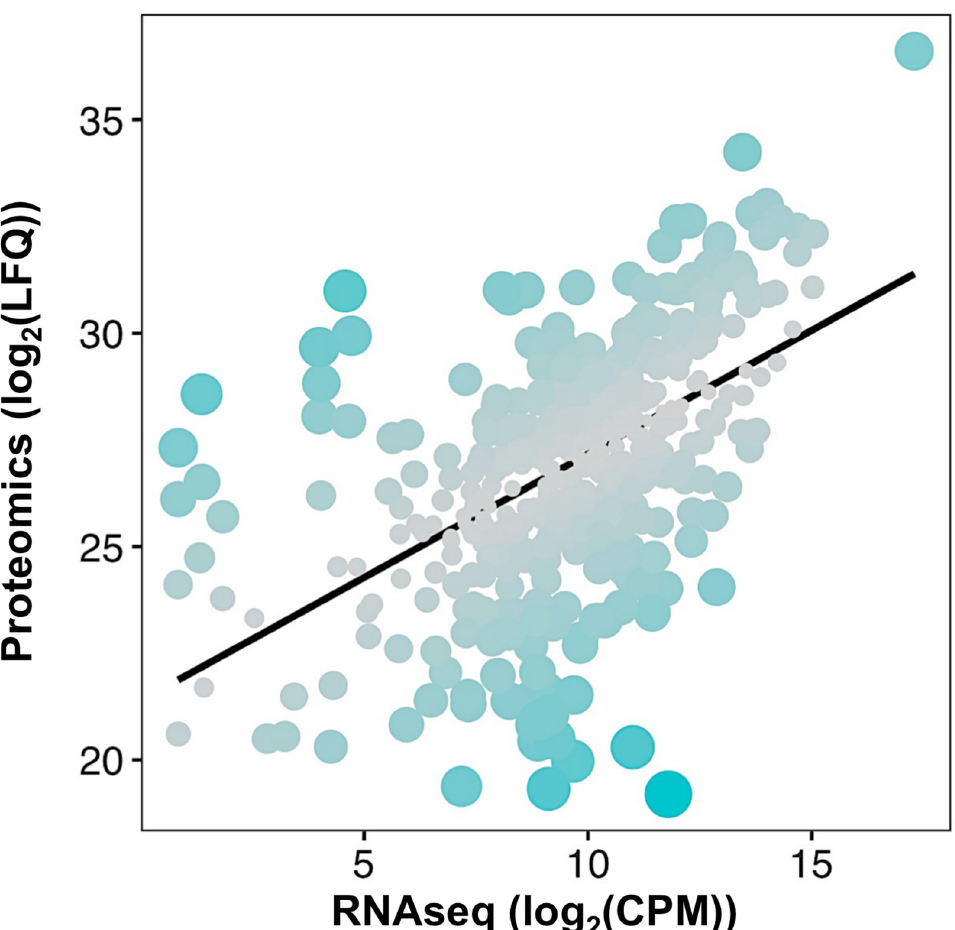
Fig 4. Spiroplasma transcription-translation correlation. Each dot represents a protein positioned according to its log 2 (LFQ; Label-free Quantification) value in the proteome versus its log 2 (CPM; Count Per Million) in the transcriptomics dataset from [23]. The black line represents the linear model log 2 (LFQ) = 0.57892 x log 2 (CPM) + 21.38325, with an adjusted R 2 = 0.2909. Dot size and color are adjusted to the residuals of the model, with bigger bluer dots indicating a higher residual hence a stronger deviation from the linear model for the considered protein.